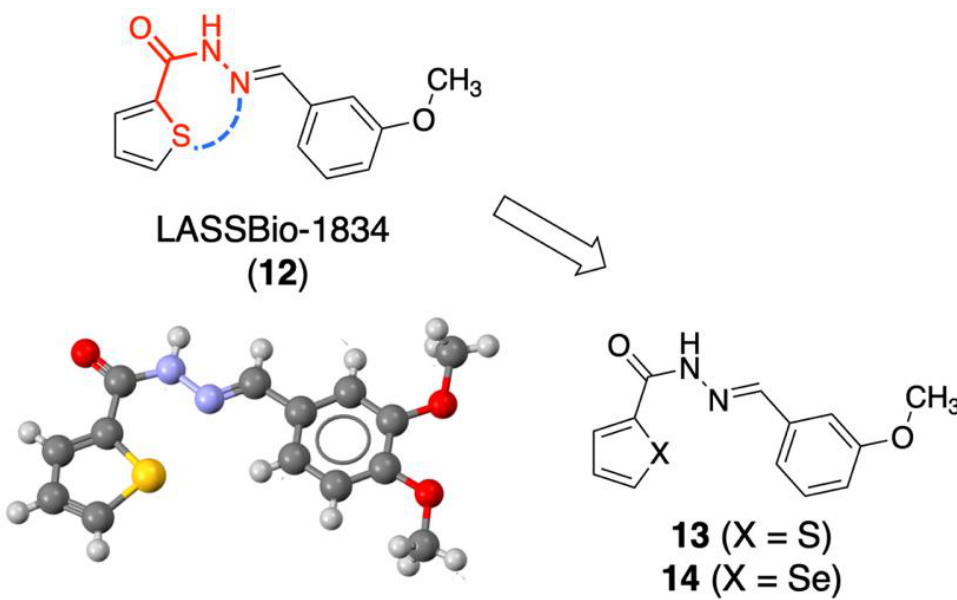
Figure 5. Chemical structure of LASSBio-1834 ( 12 ) and new isosteric analogues 13 and 14 . Represen- tation of the syn -periplanar conformation of the amide bond in the NAH due to chalcogen interaction, as observed through X-ray analysis.